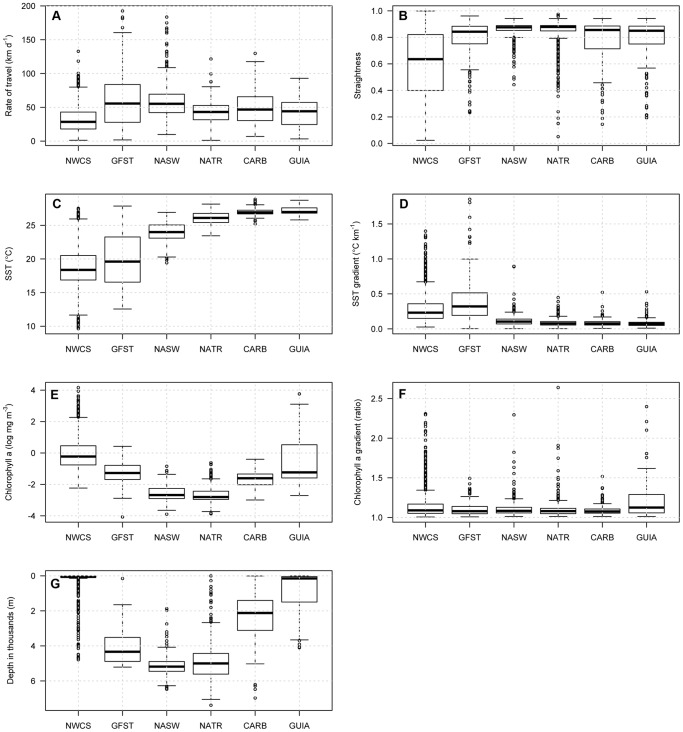
Leatherback behavioral indices in Longhurst regions of the North Atlantic Ocean.a) Rate of travel, b) straightness, c) SST, d) SST gradient magnitude, e) chl a, f) chl a gradient magnitude, and g) bathymetric depth. NWCS, Northwest Atlantic Shelves; GFST, Gulf Stream; NASW, North Atlantic Subtropical Gyral West; NATR, North Atlantic Tropical Gyral; CARB, Caribbean; GUIA, Guianas Coastal. Boxplots: centerline, median; edges of box, 1st and 3rd quartiles; whiskers, data points within the range Q1−1.5(Q3−Q1) to Q3+1.5(Q3−Q1).